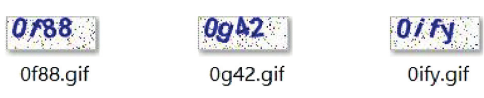
Figure 5: ZhengFang CAPTHCA.